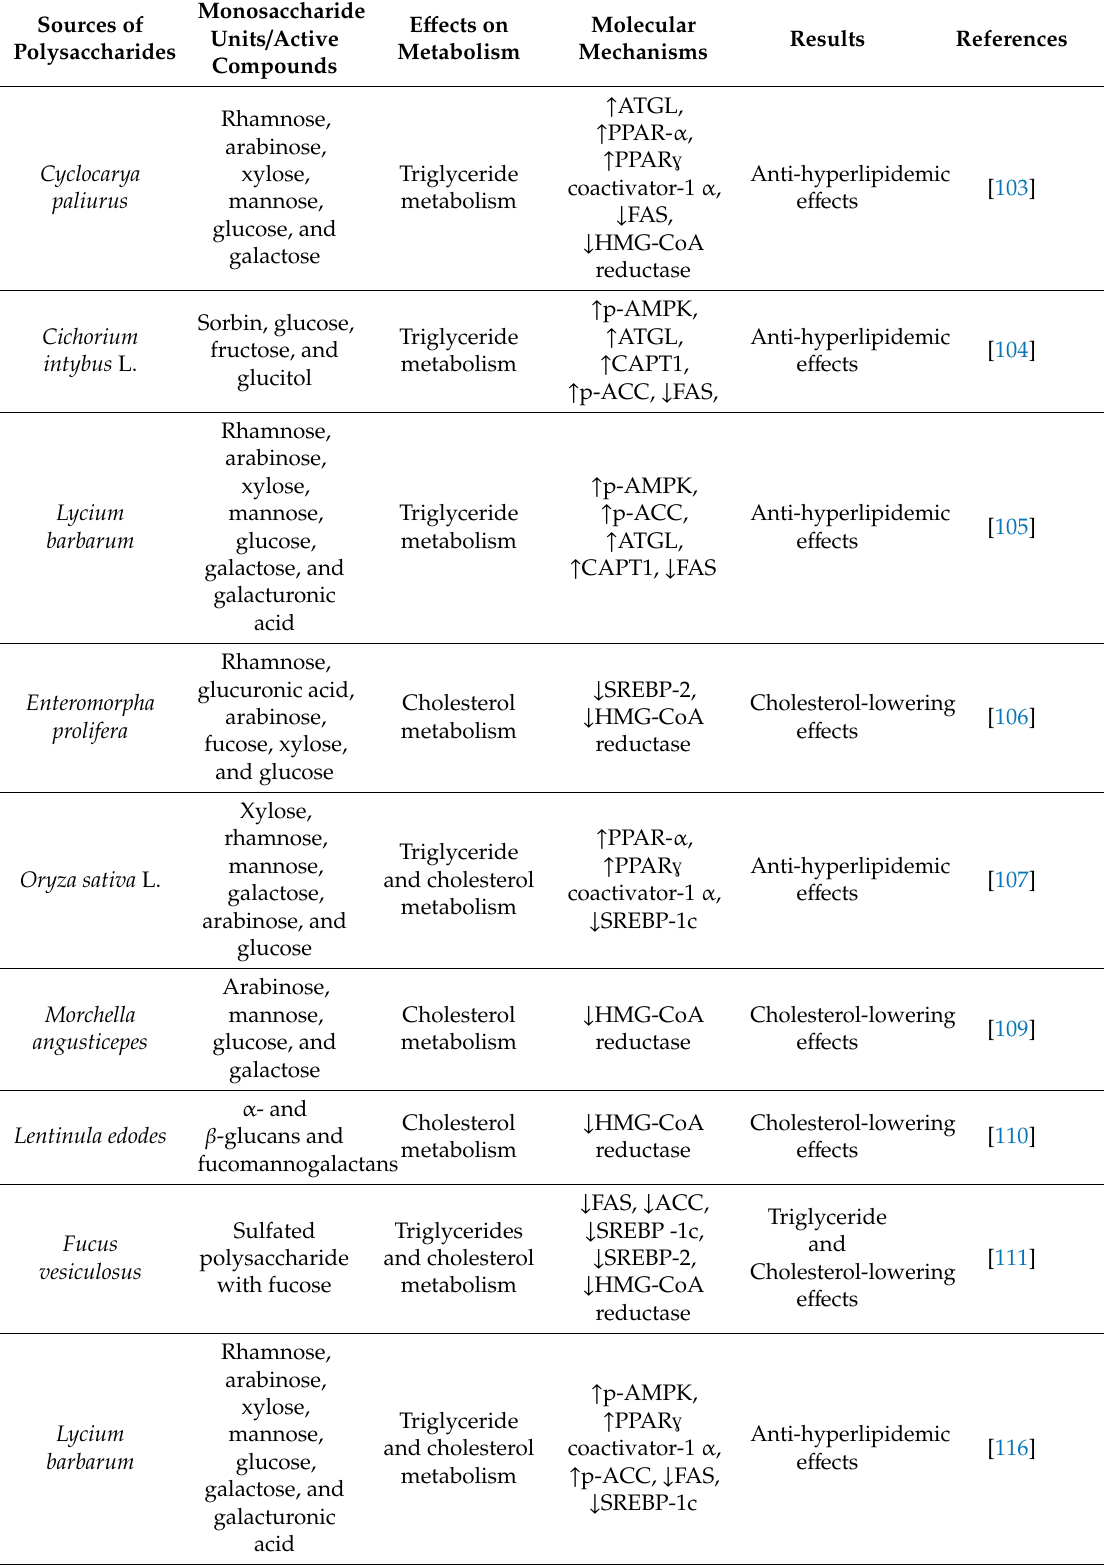
Table 2. Anti-cholesterolemic and anti-triglyceridemic e ff ects of dietary polysaccharides. Sources